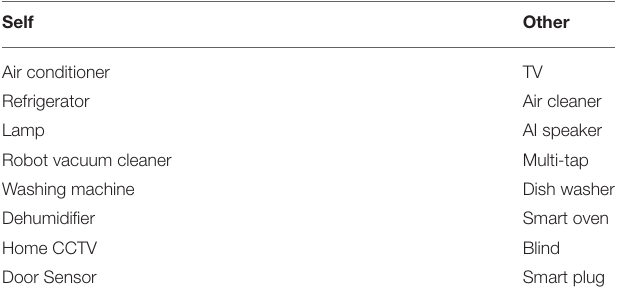
TABLE 1 | List of primary user-specific smart home devices in Experiment 1.